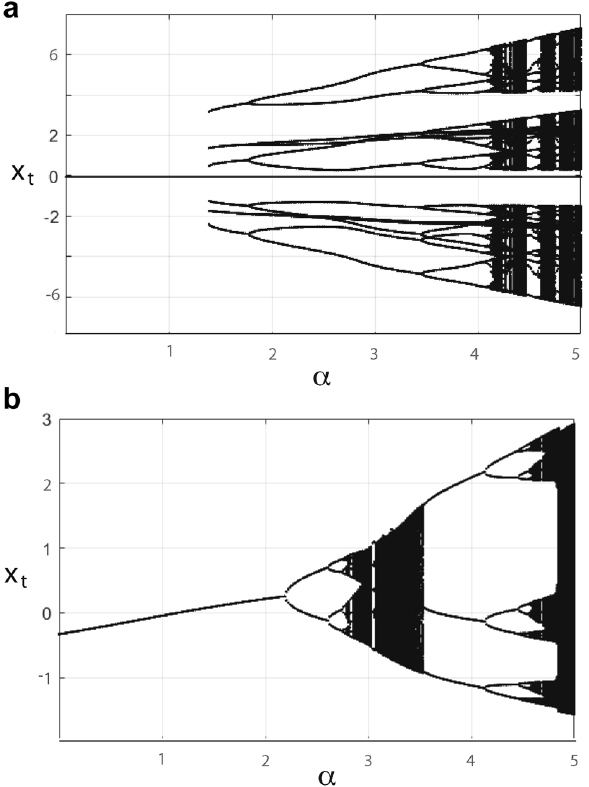
4, β 1, δ 0, γ 1, η 0.05, µ 0.9 and ( b ) = = = = = − = 0.0025 , for different values of α . Last 200 steps from =